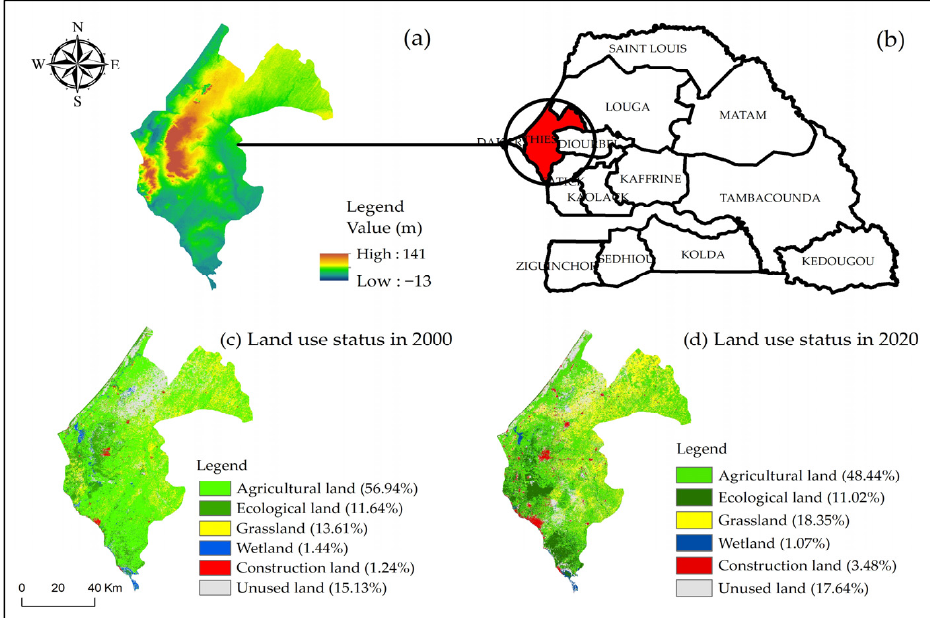
Figure 1. Description of the main features of the study area. ( a ) Digital Elevation Model (DEM); ( b ) Senegal’s administrative limits regions, ( c , d ) the land use status in 2000 and 2020, respectively. The topography is flat except for the “Plateau of Thi è s,” which culminates at 141 m altitude. The temperatures are generally high, and the annual temperature cycle is